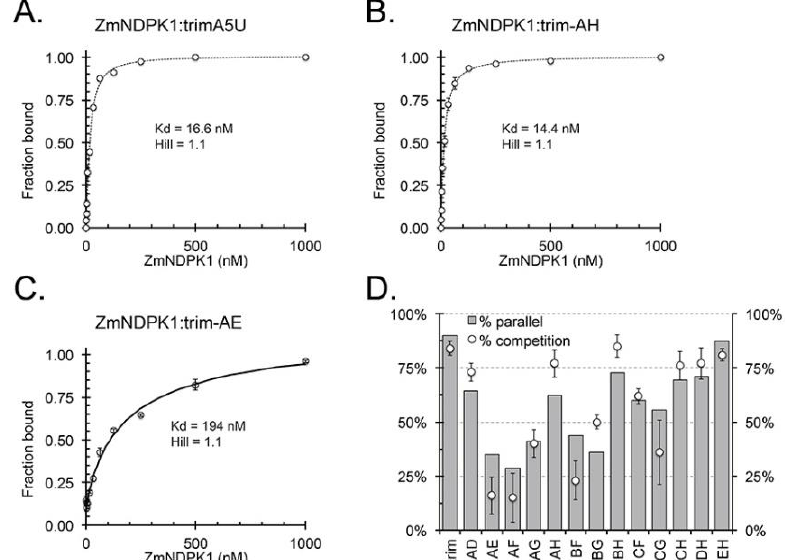
Figure 8. G4-binding protein ZmNDPK1 preferentially binds to the parallel locked variants of trim_A5U. ( A ) Binding of ZmNDPK1 to the trim_A5U caused the retention of the fluorescently labeled oligonucleotide on the nitrocellulose. ( B ) Binding of ZmNDPK1 to the trim_AH caused the retention of the fluorescently labeled oligonucleotide on the nitrocellulose. ( C ) Binding of ZmNDPK1 to the trim_AE caused the retention of the fluorescently labeled oligonucleotide on the nitrocellulose. ( D ) Competition efficiency was calculated as the amount of the probe retained on the nitrocellulose compared to the no-competitor control. Only parallel G4-locked variants competed with high efficiency: A5U AD , A5U AH , A5U BH , A5U CF , A5U CH , A5U DH , and A5U EH .